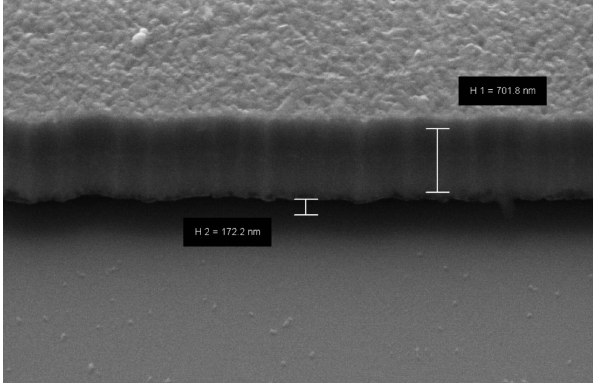
of the suspended beams.